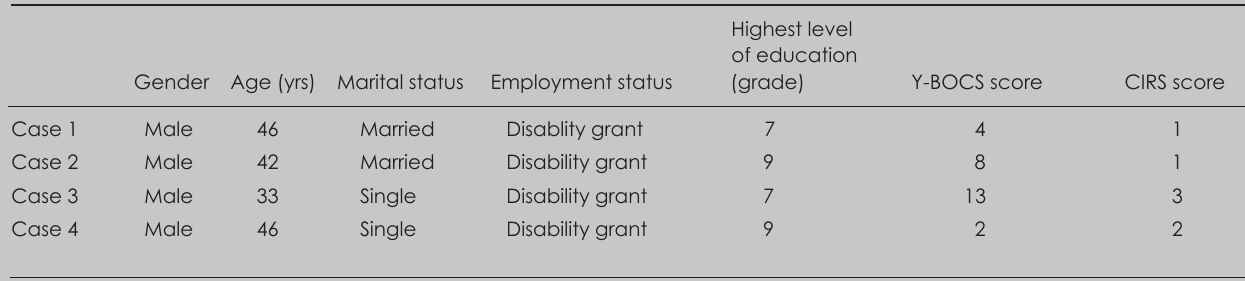
Table I. Demographic variables and assessment scores of